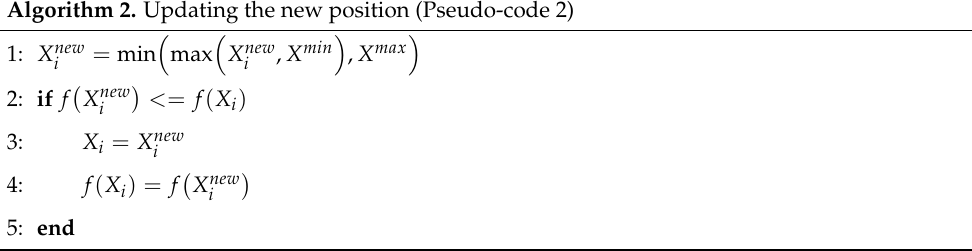
Algorithm 2. Updating the new position (Pseudo-code 2)